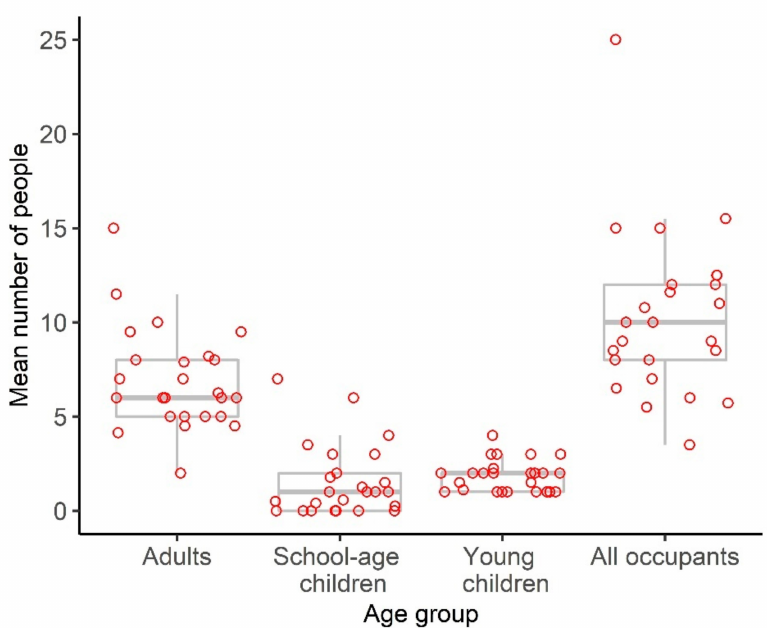
Figure 2. Distribution of the mean number of people per dwelling by age group. Each dot represents the mean number of individuals of a specific age across all survey responses for a given dwelling. The median of the means is represented using the thick grey line and the interquartile range of the means with the thinner grey lines.